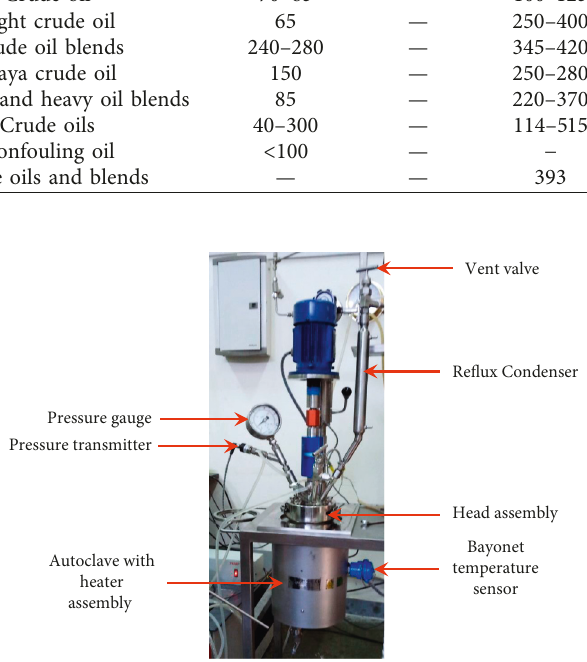
Figure 1: Photograph of the test